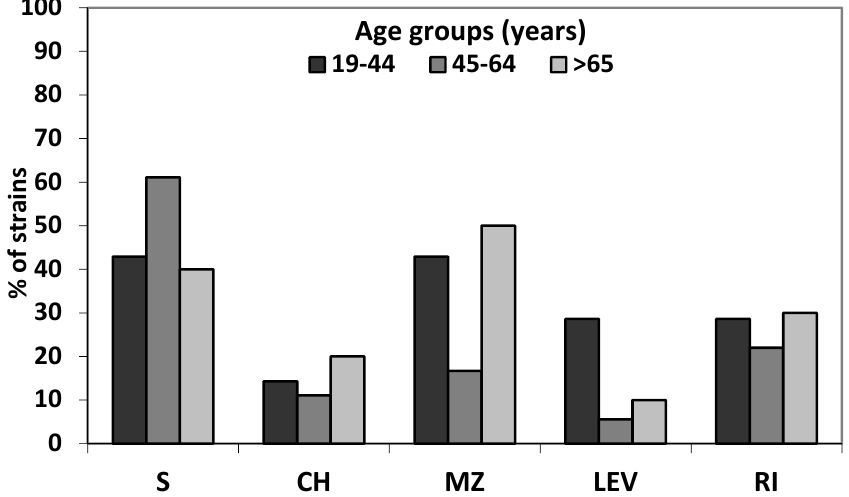
Figure 2. Resistance to tested antibiotics of 35 isolates H. pylori strains in different age groups (S— sensitive to all tested antibiotics; CH—clarithromycin; MZ—metronidazole; RI—rifampicin; LEV— levofloxacin).